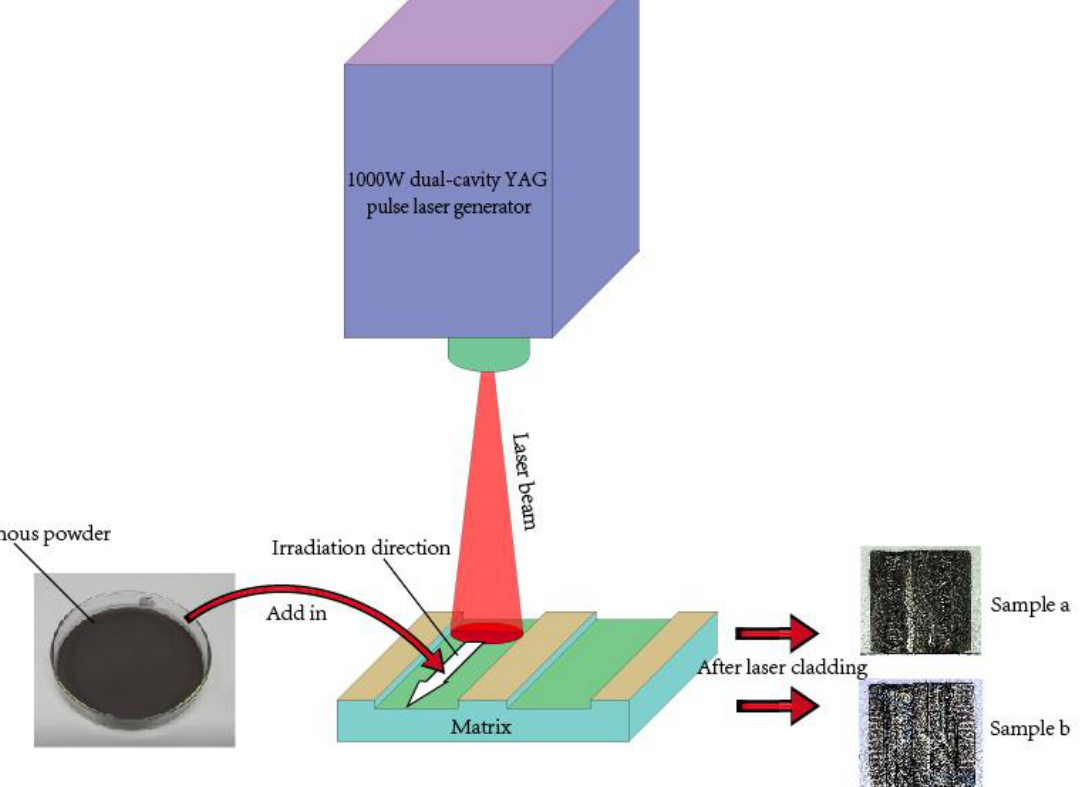
Figure 1. The schematic diagram of the sample preparation process. Table 4. Parameters of friction and